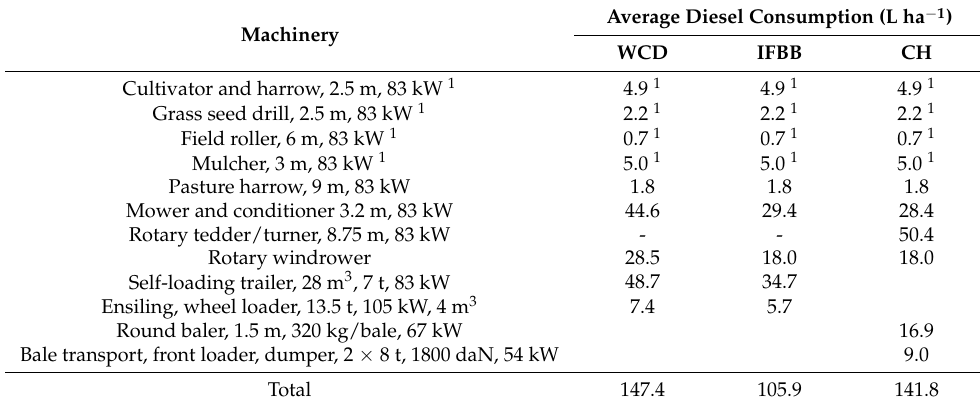
Table 1. Field operation data applied to grassland biomass to prepare it for combustion of hay (CH), integrated generation of solid fuel and biogas from biomass (IFBB) and whole crop digestion (WCD). A farm to field distance of 5 km and a field size of 4 ha was assumed. Data are mean values for all agroforestry and grassland treatments accumulated over three years (second rotation)